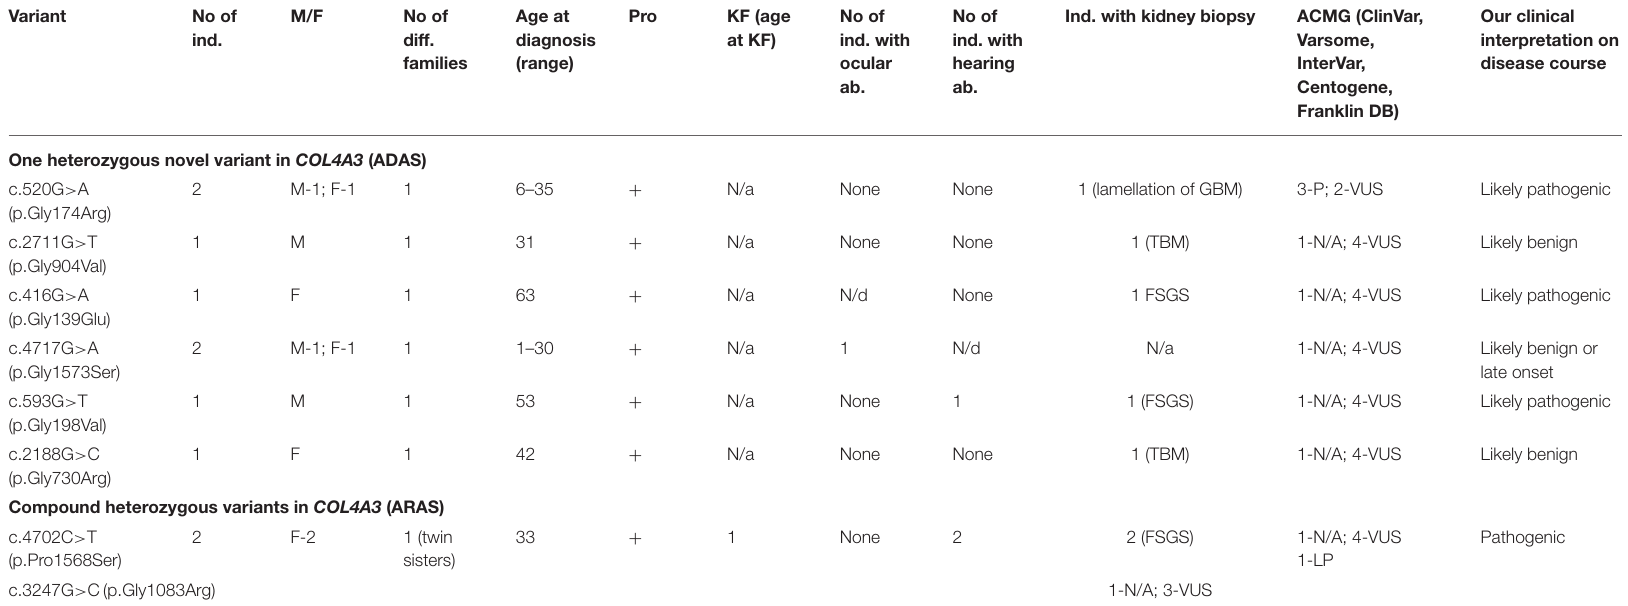
TABLE 5 | Summary of novel COL4A3 variants found in a study (ARAS and